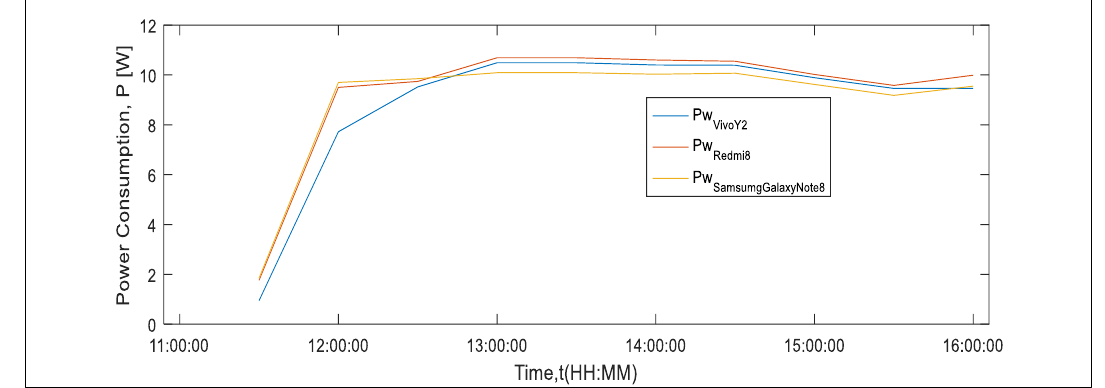
Figure 6: MPs Power Consumption.